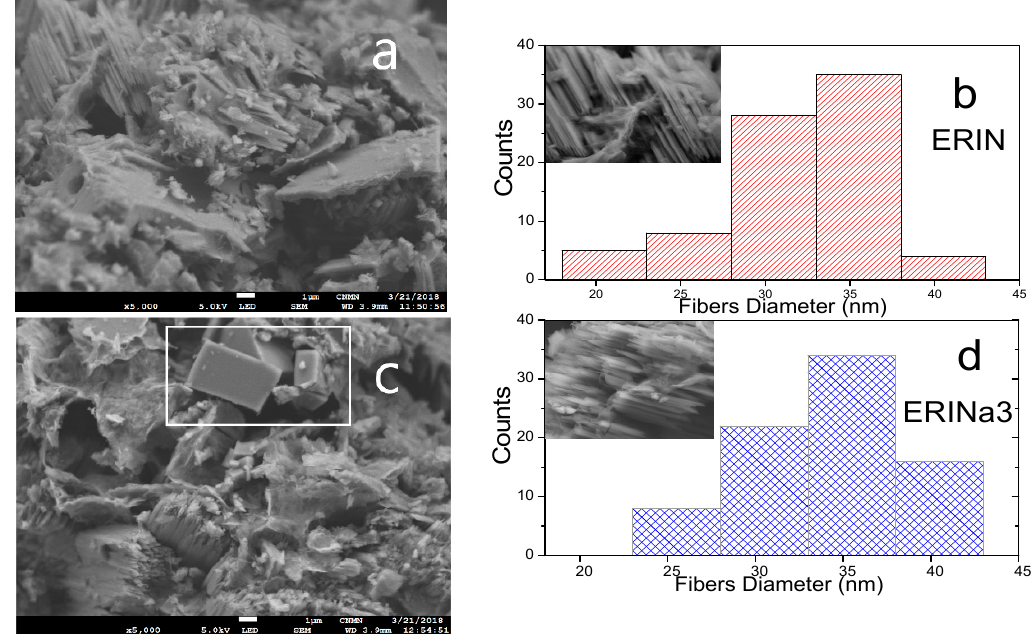
Figure 2. HR-SEM images of erionite fibers: ( a ) ERIN—5000×, ( b ) Histogram of ERIN diameter, ( c ) ERINa3—5000×, ( d ) Histogram of ERINa3 diameter.